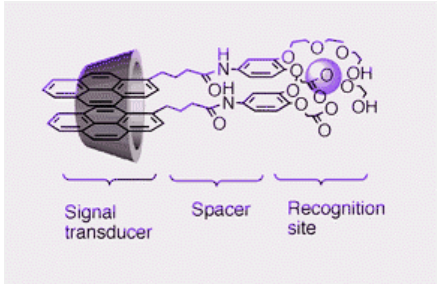
Figure 43. Podand fluoroionophore/ -cyclodextrin ( -CyD)